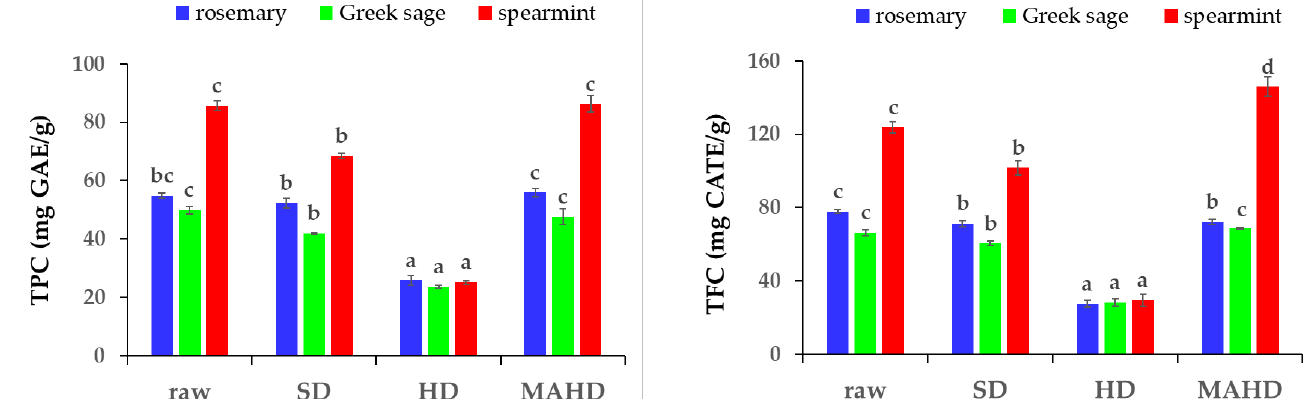
Figure 1. Total phenolic content (TPC) and total flavonoid content (TFC) in methanolic extracts from raw and distillation solid residues of rosemary, Greek sage and spearmint, remained after the recovery of essential oil by steam distillation (SD), hydro-distillation (HD) and microwave-assisted hydro-distillation (MAHD). Different letters among columns with the same color indicate statistically significant differences based on Duncan’s post-hoc test ( p ≤ 0.05).